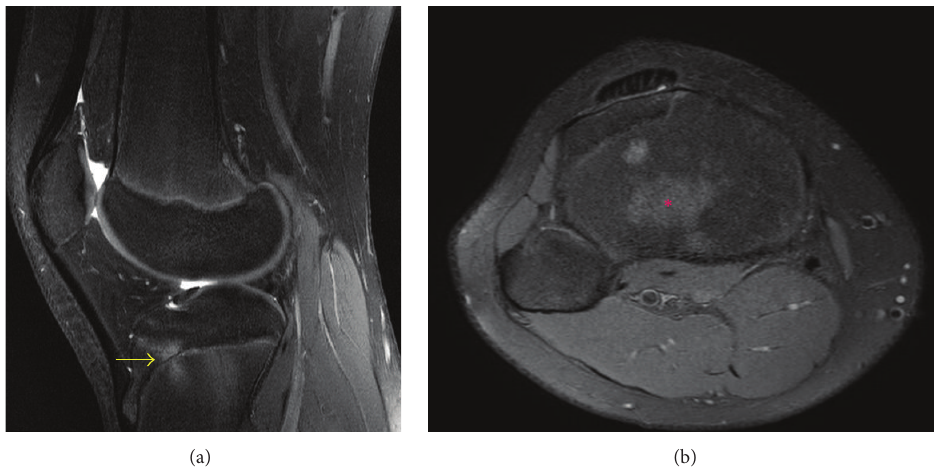
Figure 4: A 13-year-3-month-old female with FOPE zones at both proximal tibiae. Findings: (a) sagittal proton density fat-saturated image on the 6-month follow-up MRI of the right knee shows interval development of 9 mm in diameter area of periphyseal edema on both the epiphyseal and metaphyseal sides of the proximal tibia physis (arrow). The proximal tibia physis is narrowed but remains open. (b) Axial proton density fat-saturated image at the level of the proximal tibia physis shows the periphyseal edema located at the anterolateral aspect of the central physis (asterisk). Technique: (a) sagittal PD fat-saturated MRI (TR = 2,958.3, TE = 30), ST = 3 mm, spacing = 3.3 mm, FOV = 14cm, and matrix = 364 × 261; (b) axial PD fat-saturated MRI (TR = 2,843.3, TE = 30), ST = 3 mm, spacing = 3.3 mm, FOV = 15cm, and matrix = 376 × 297.